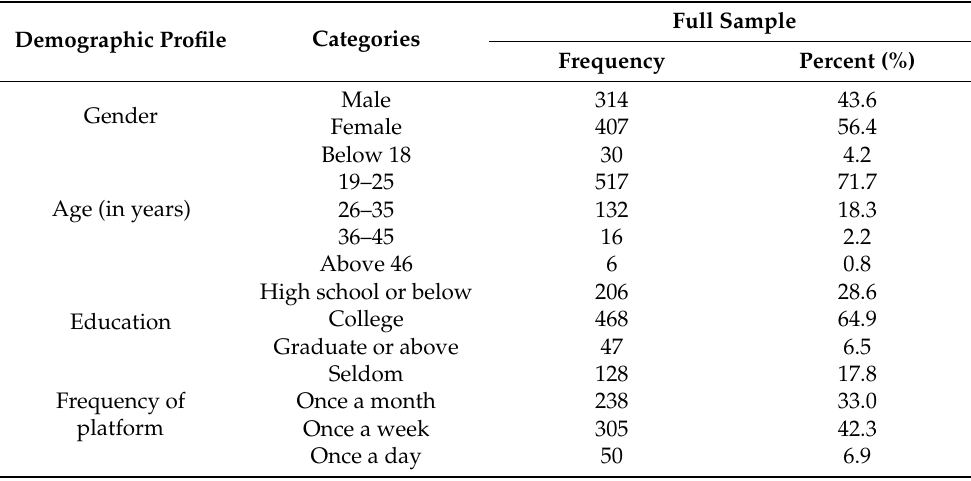
Table 1. Demographics of survey respondents ( N =